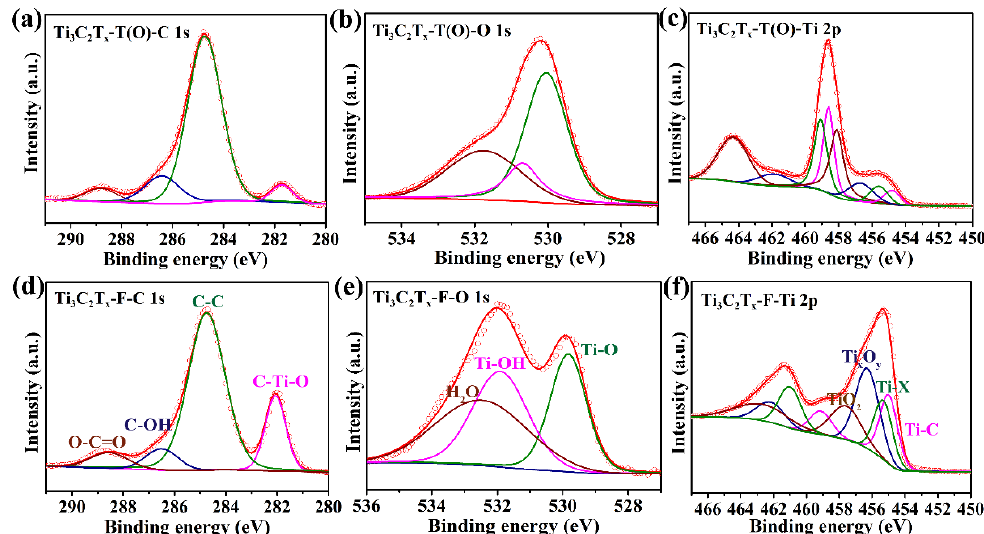
Figure 4. XPS spectra for high-resolution ( a ) and ( d ) C 1 s ; ( b ) and ( e ) O 1 s ; ( c ) and ( f ) Ti 2 p of Ti 3 C 2 T x -T(O) and Ti 3 C 2 T x -F.